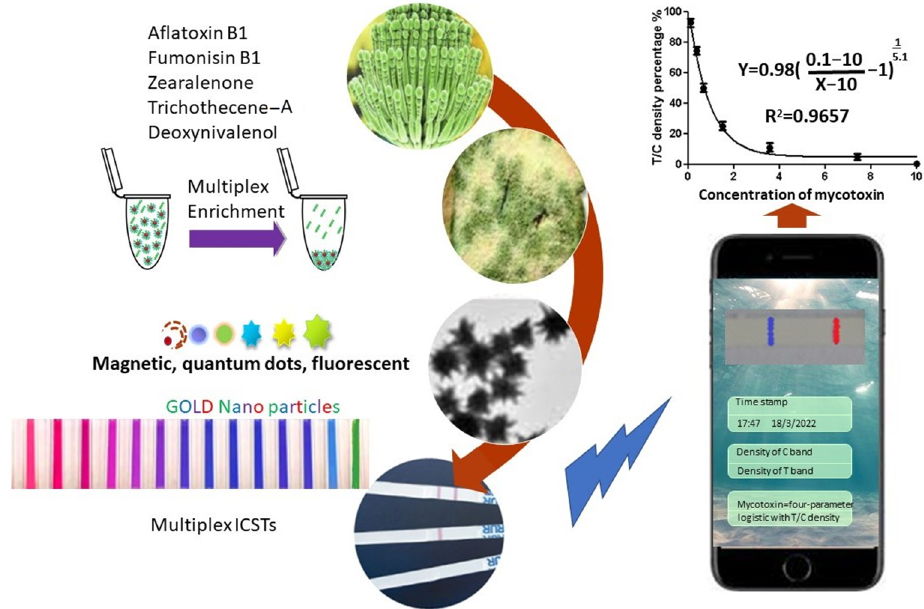
Figure 6. Schematic diagram of measurement protocol for various types of mycotoxins using mul- tiplex enrichment for samples and various nanoparticles, based on laminar flow strips and using a smartphone.